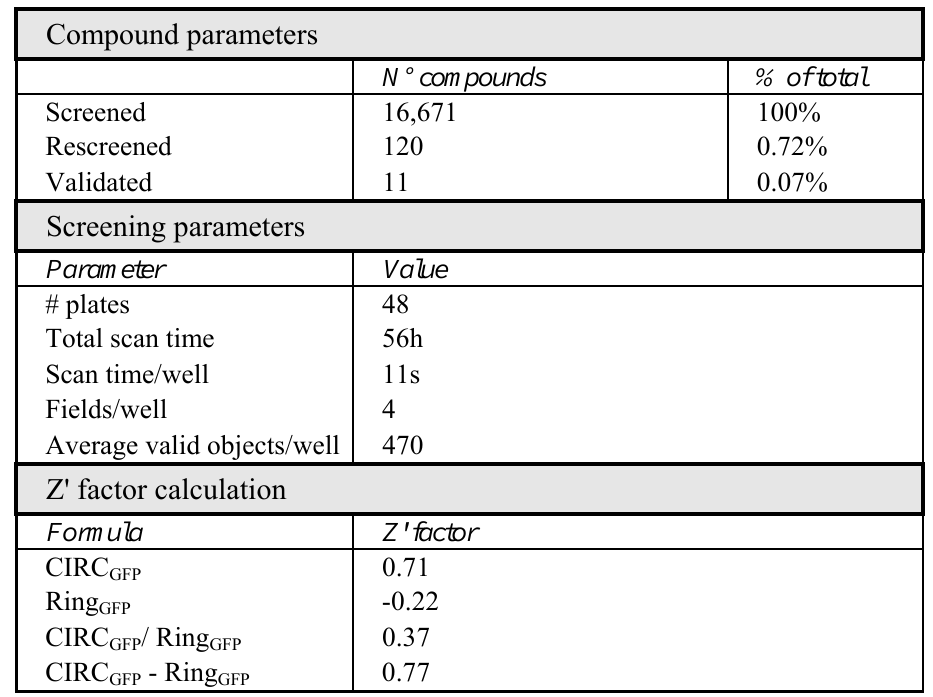
Table 1. Translocation screen summary and assay performance